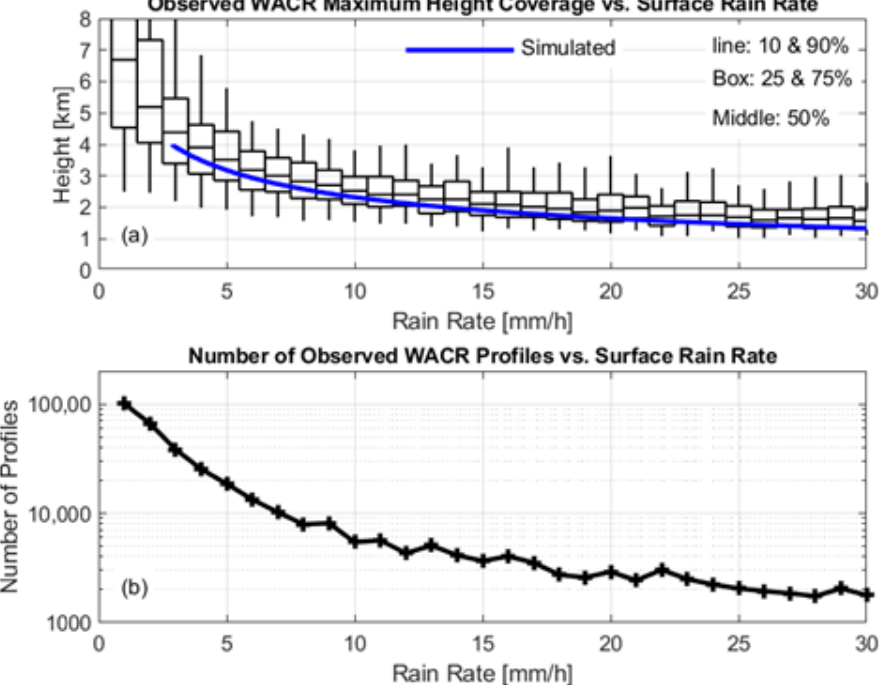
Figure 11. Observed WACR maximum height as a function of simultaneous surface rain rate. ( a ) Box whisker plot of observed WACR maximum height, center line is median, box edges are 25 and 75 percentiles, and whisker tips are 10 and 90 percentiles. The blue line is the simulated W-band WACR maximum height shown in Figure 10. ( b ) Number of WACR profiles for each surface Parsivel disdrometer rain rate. Over 370,000 WACR profiles were observed when Parsivel disdrometer rain rates were greater than 0.5 mm h −1 between September 2014 and November 2015.